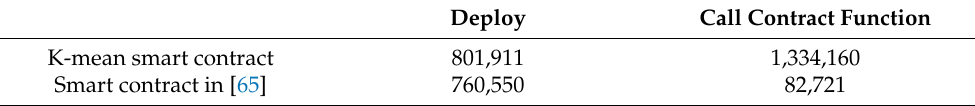
Table 1. Gas consumption.